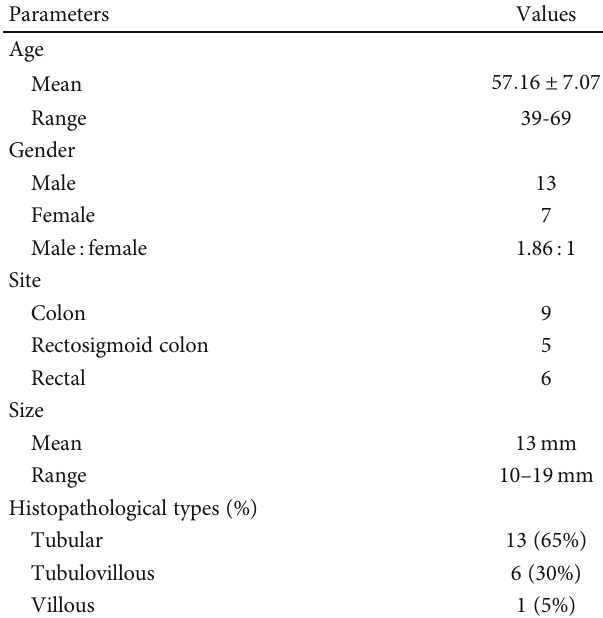
Table 1: Parameters of